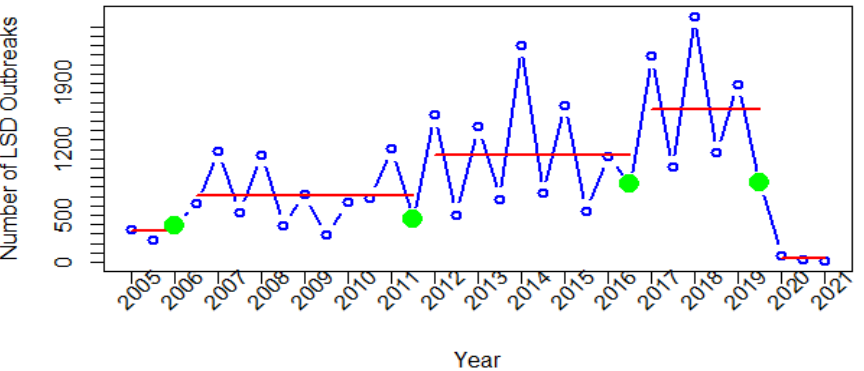
Figure 5. Change points in time series of LSD outbreak reports in Africa. Green dots are change points, and red lines are corresponding segments.